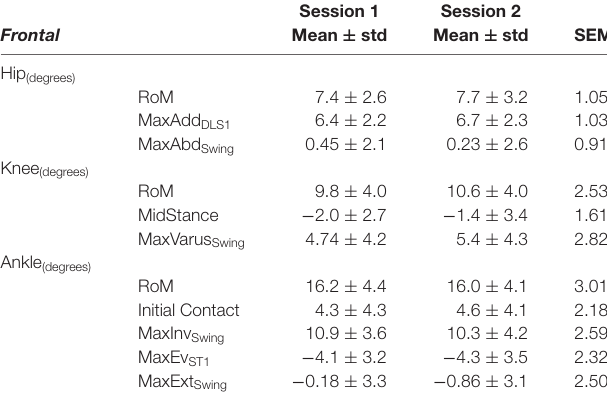
TABLE 4 | Frontal plane variables—Self-Selected Walking Speed: mean ± standard deviation (std) for Session 1 and Session 2, and Standard Error of Measurement (SEM).